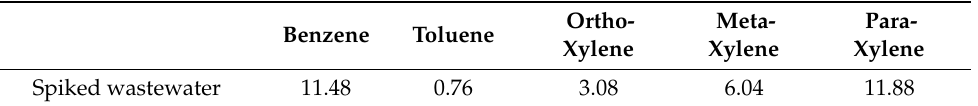
Table 2. Benzene, toluene, ortho-, meta-, and para- xylenes (BTX) concentration (ppm) of the spiked wastewater determined by GC-MS.